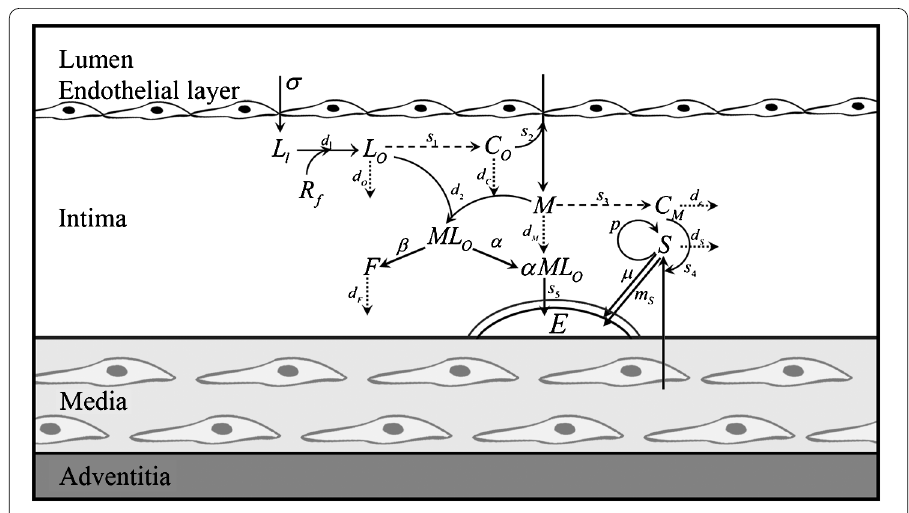
Figure 2 Diagram showing the reactions among the variables modeled in